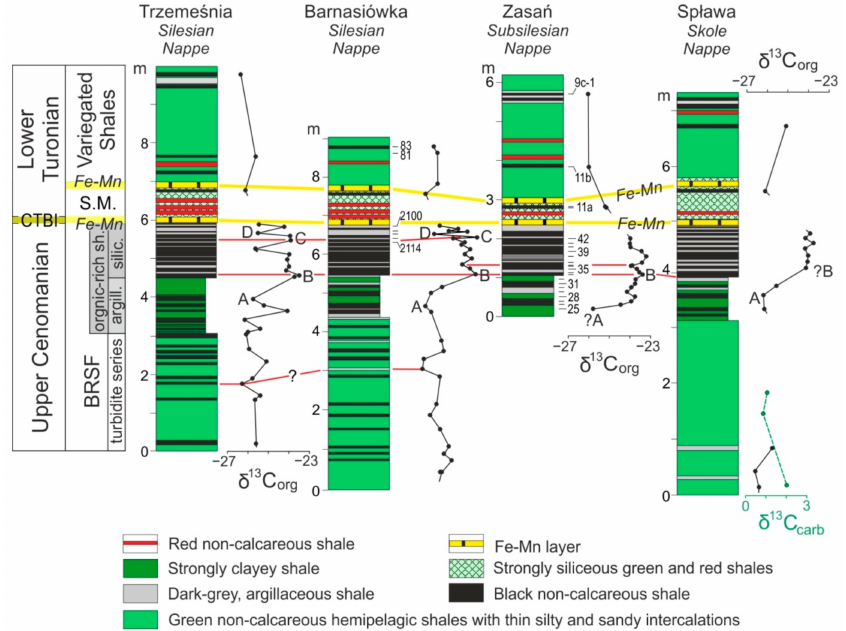
Figure 3. Lithological logs of the Outer Carpathian sections plotted against organic carbon isotope data (partly based on B ˛ak K [14–17], see also Table S1); CTBI—Cenomanian–Turonian boundary interval; Fe–Mn—ferromanganese layer, S.M.—siliceous-manganiferous green and red shales. A, B, C, D—chemostratigraphic marker points used for correlation. Note that the C–T boundary was determined on the basis of organic carbon stable isotope data; this is placed within a first Fe–Mn chronohorizon that represents a stratigraphic interval coinciding with the condensation of time. The measurement points marked in green apply to δ 13 C carb